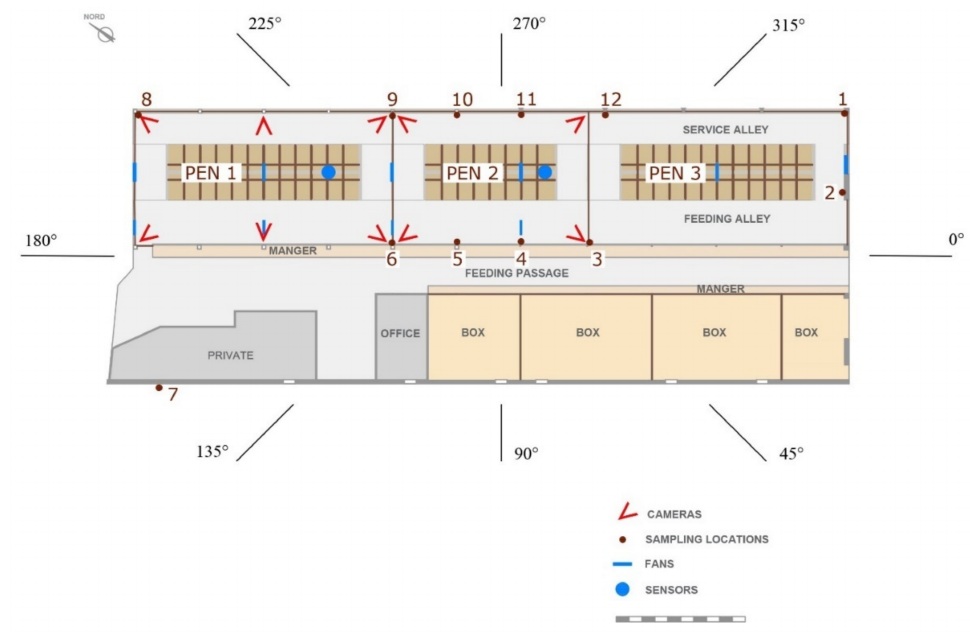
Figure 1. Plan of the barn under study, with location of the axial-flow fans and the monitoring systems. Degree values indicate the direction of airflow in the reference system of the anemometers.